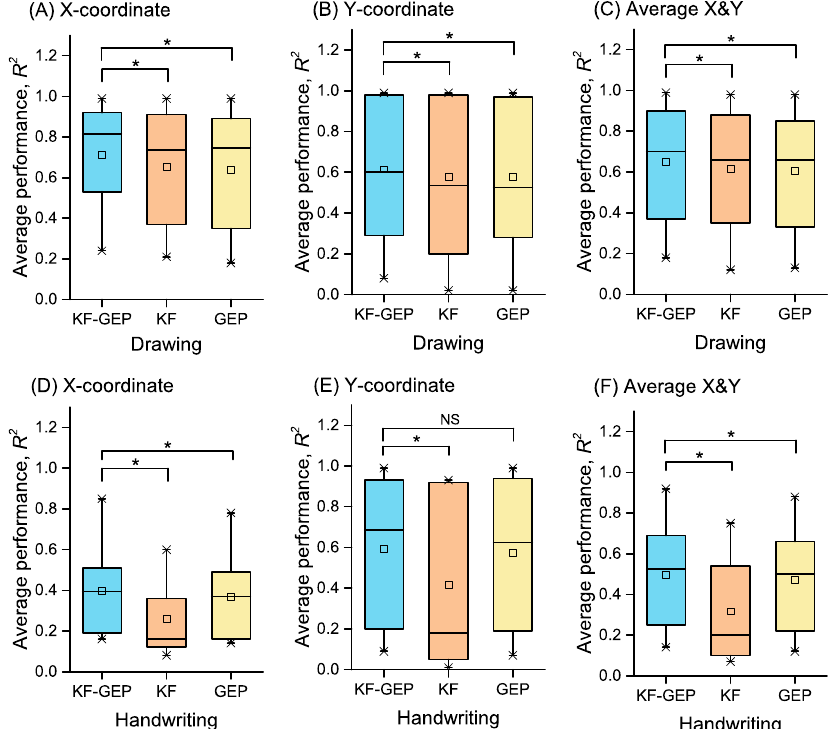
Figure 17. The averages of R 2 s in within-group reconstruction achieved by three methods. Statistical difference between the KF-GEP and KF and between the KF-GEP and GEP was measured by paired sample Wilcoxon signed-rank test: * the KF-GEP’s performance do significantly tends to be greater than the KF’s and GEP’s at the 0.05 level.